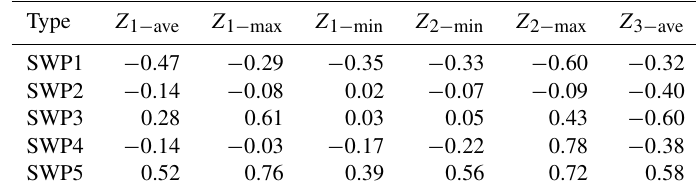
Table 4. Correlation coefficients between EOF1 time series and different SWPIIs under each SWP.